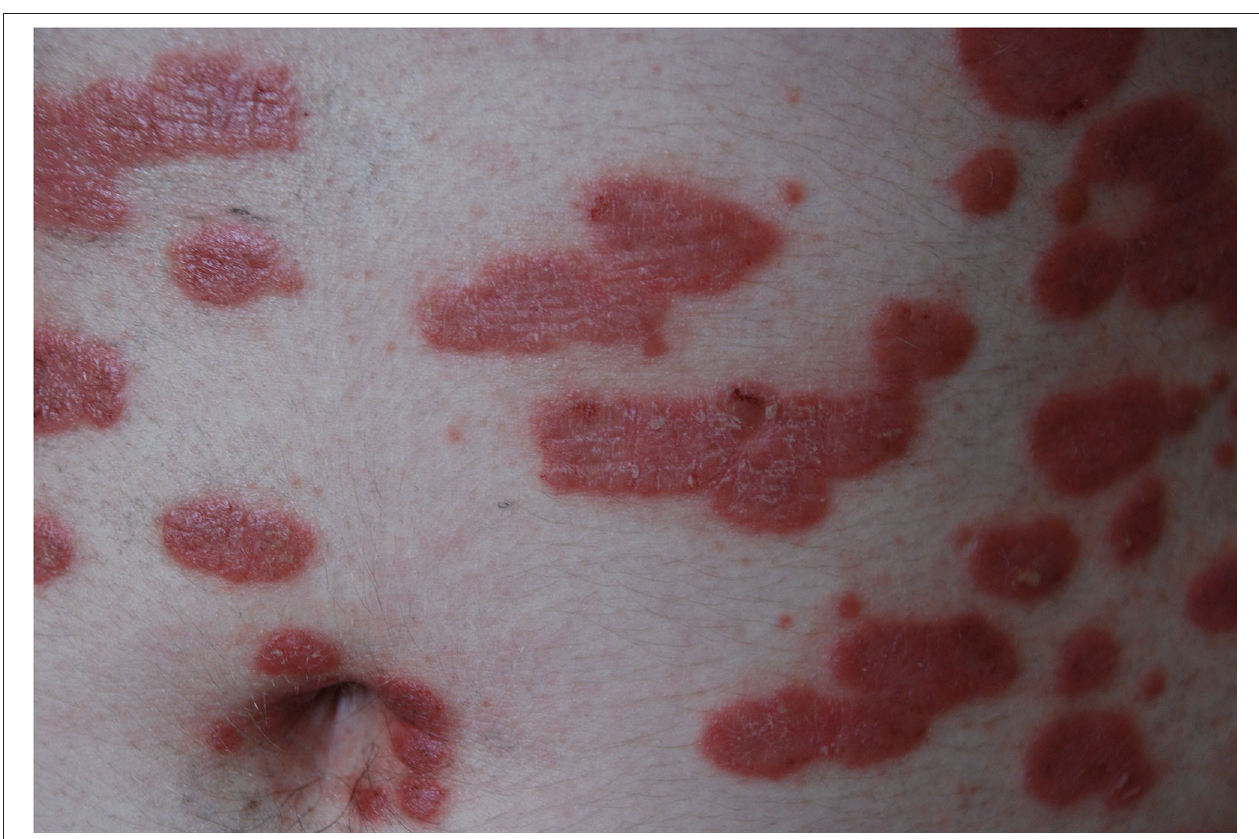
FIGURE 2 | Erythematous-infiltrative psoriatic lesions on the trunk (from the archives of Dermatology